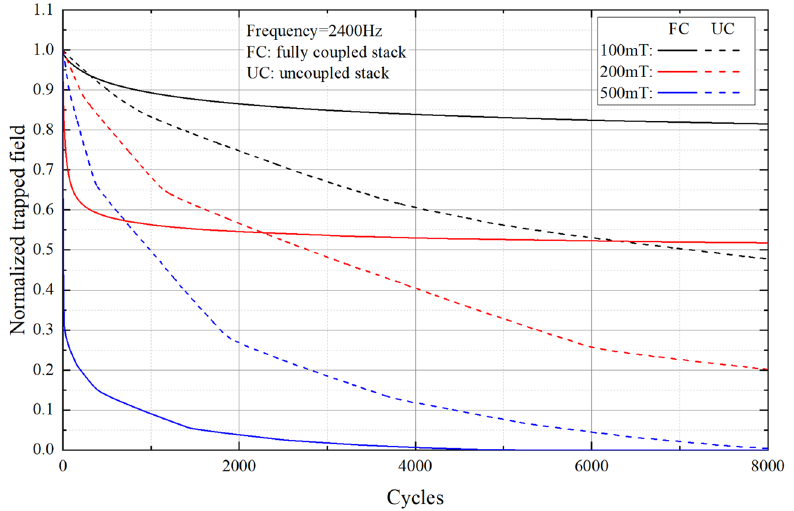
Figure 3. Normalized trapped field of the fully coupled stack and the uncoupled stack with a serious of cross- field amplitudes at frequency 2400 Hz. The solid lines are the fully coupled stack and the dash lines are the uncoupled stack,